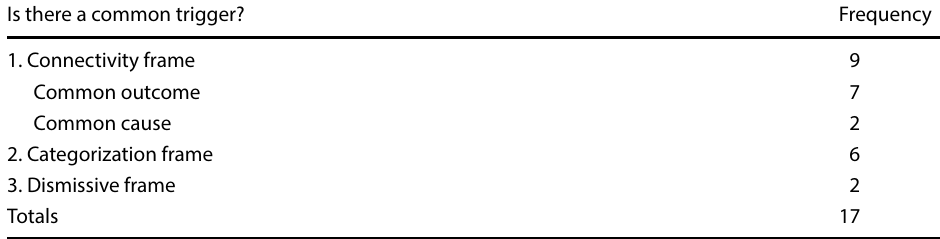
Is there a common